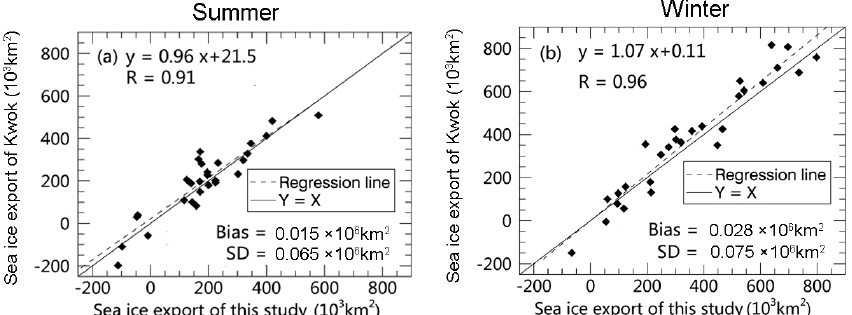
Figure 2. Comparison of regional sea ice exchanges between the PA and AA sectors in (a) summer and (b) winter. Our estimates are compared with a previous 29-year record (1979–2007) provided by Kwok (2008b). The dashed line is the linear fit line between the two estimates. The solid line denotes the “ Y = X ” line. The linear relationship equation and correlation coefficient ( R ) between the two records, as well as the mean bias and standard deviation (SD) of the difference, are also